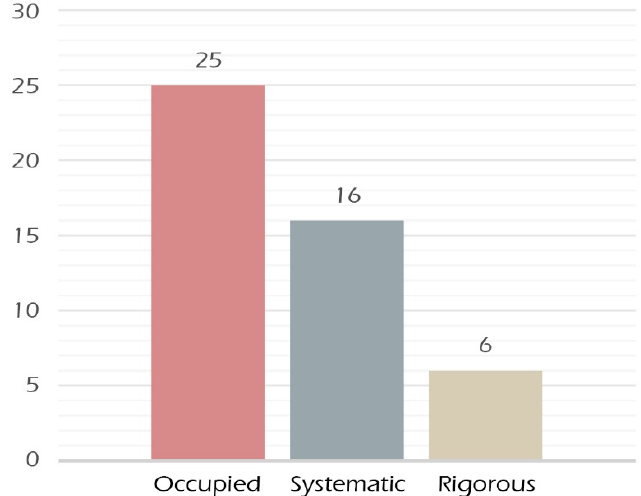
Figure 5. Agreements identified from the collected definitions.